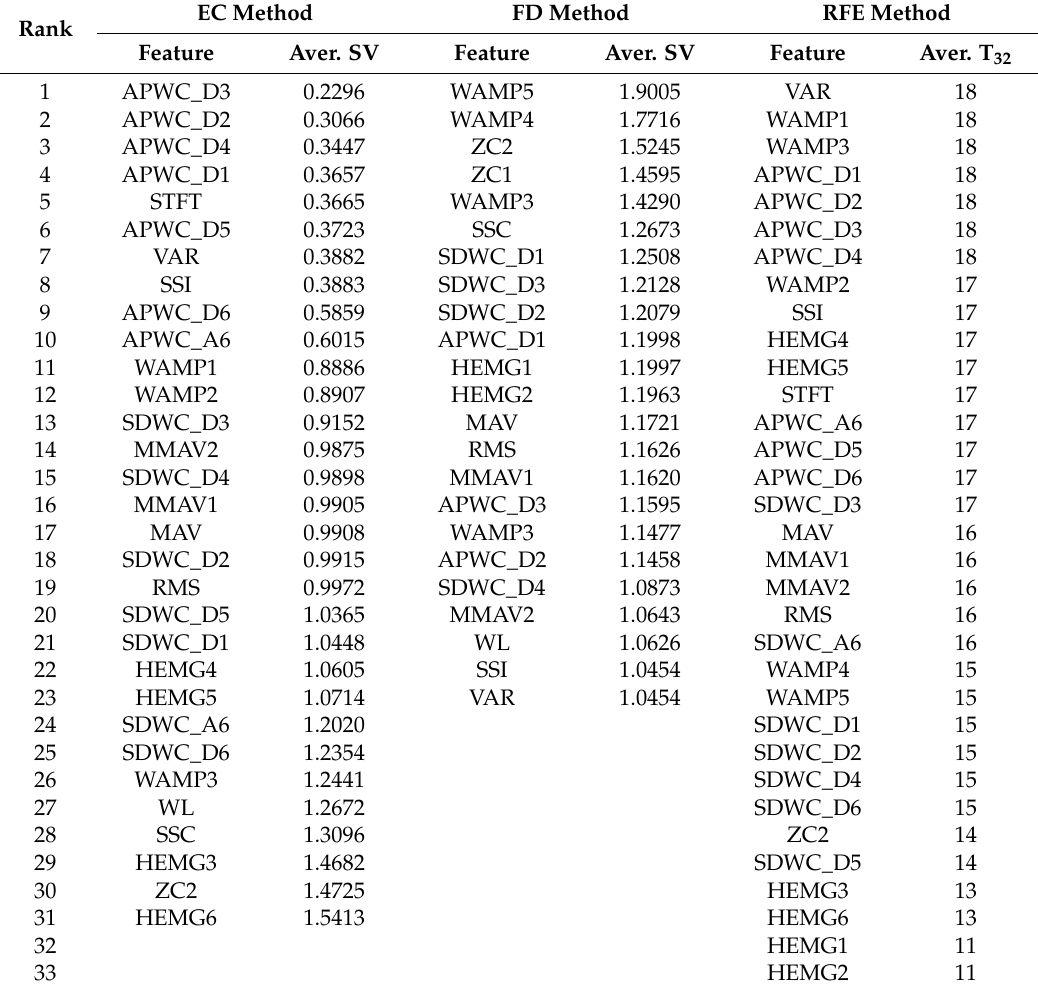
Table 7. The selected features and SV